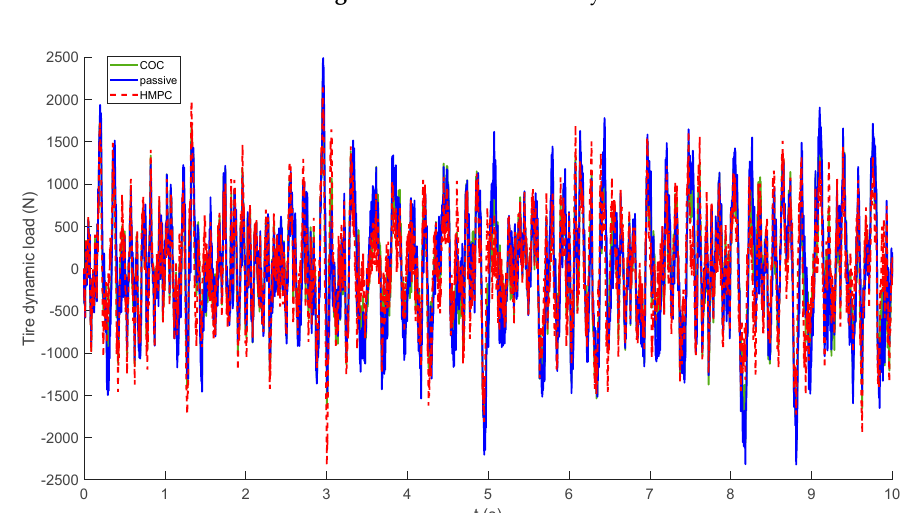
Figure 19. Motor eccentricity.